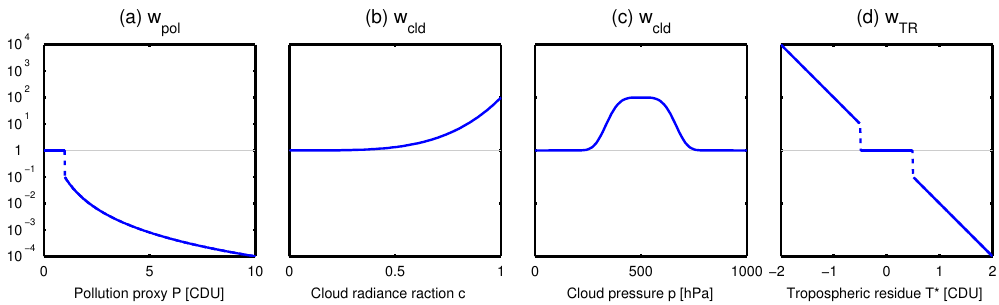
Figure 1. Definition of weighting factors (a) w pol as a function of the pollution proxy P (Eq. 5), (b) w cld as a function of the cloud radiance fraction (Eq. 6) for a cloud pressure of 500hPa, (c) w cld as a function of the cloud pressure (Eq. 6) for a cloud radiance fraction of 1, and (d) w TR as a function of the tropospheric residue (Eq.